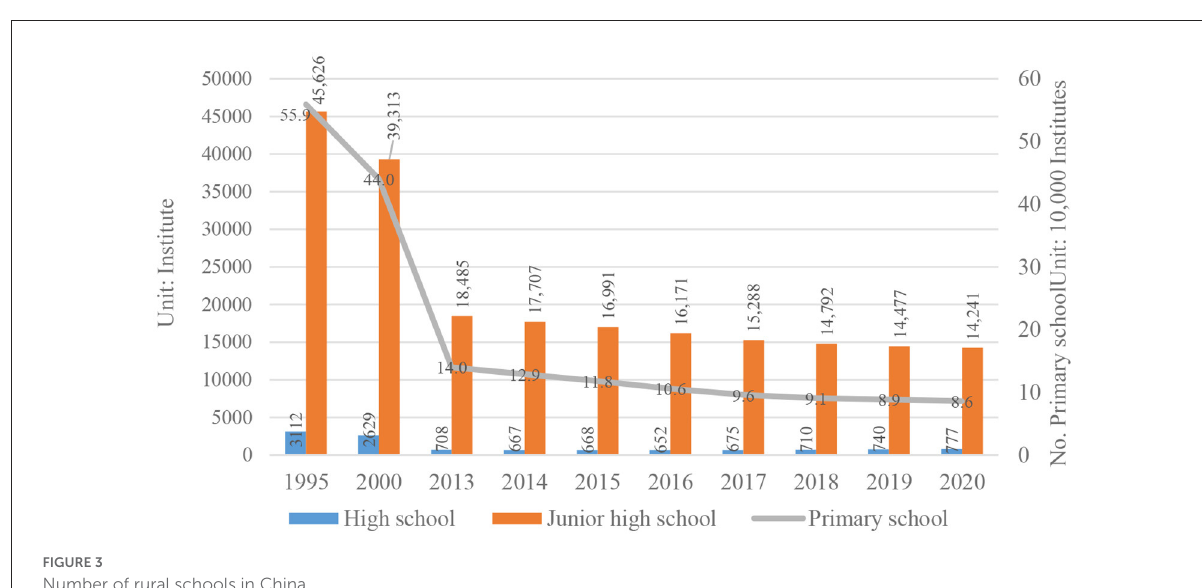
FIGURE3 Number of rural schools in